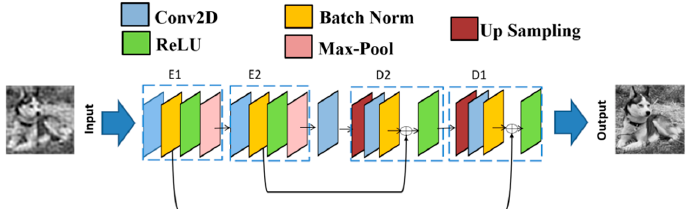
Figure 1. Deep convolutional autoencoder network (DCAN) architecture used in deep learning-Fourier single pixel imaging (DL-FSPI).